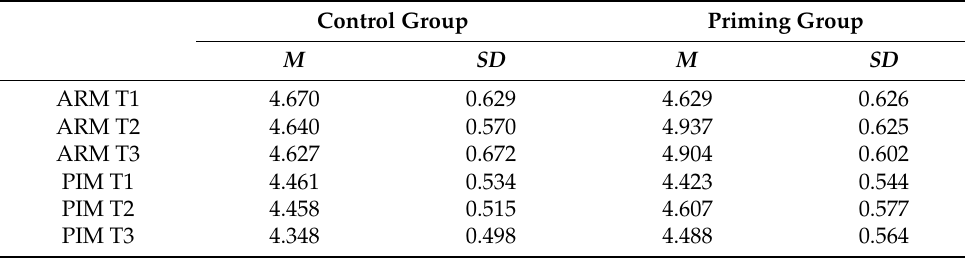
Table 1. Descriptive statistics at different time points in Study